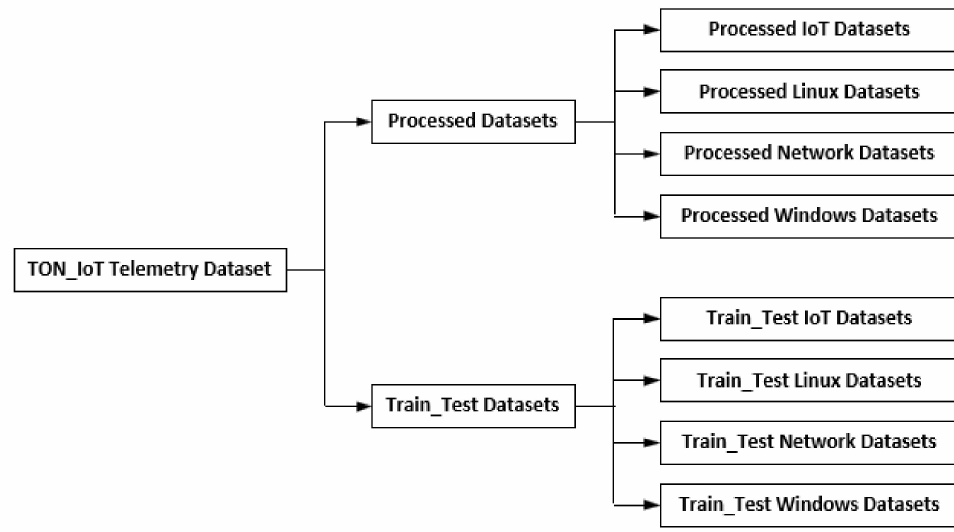
Figure 1. ToN_IoT Telemetry datasets hierarchy.